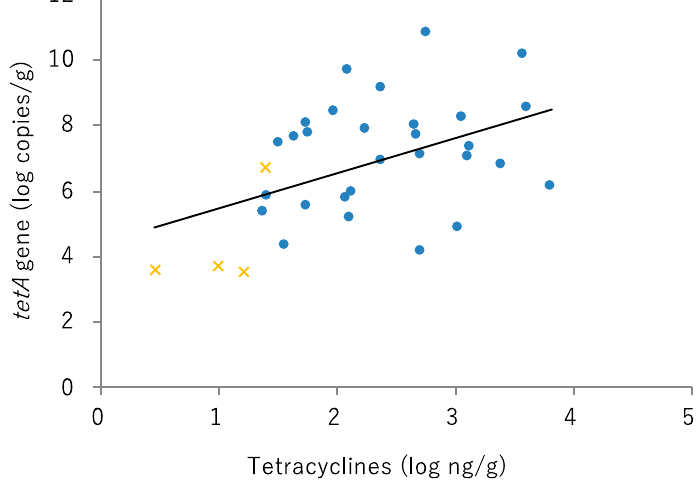
Figure 3. Relationship between tetA gene copy number and concentration of residual tetracyclines in manure compost. Manure compost derived from pig farm: blue dot; manure compost derived from cow farm: orange cross.